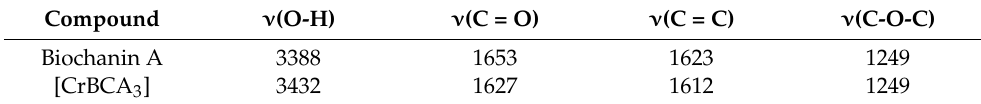
Table 2. The primary IR spectral data of biochanin A and the chromium complex (cm − 1 ). Compound